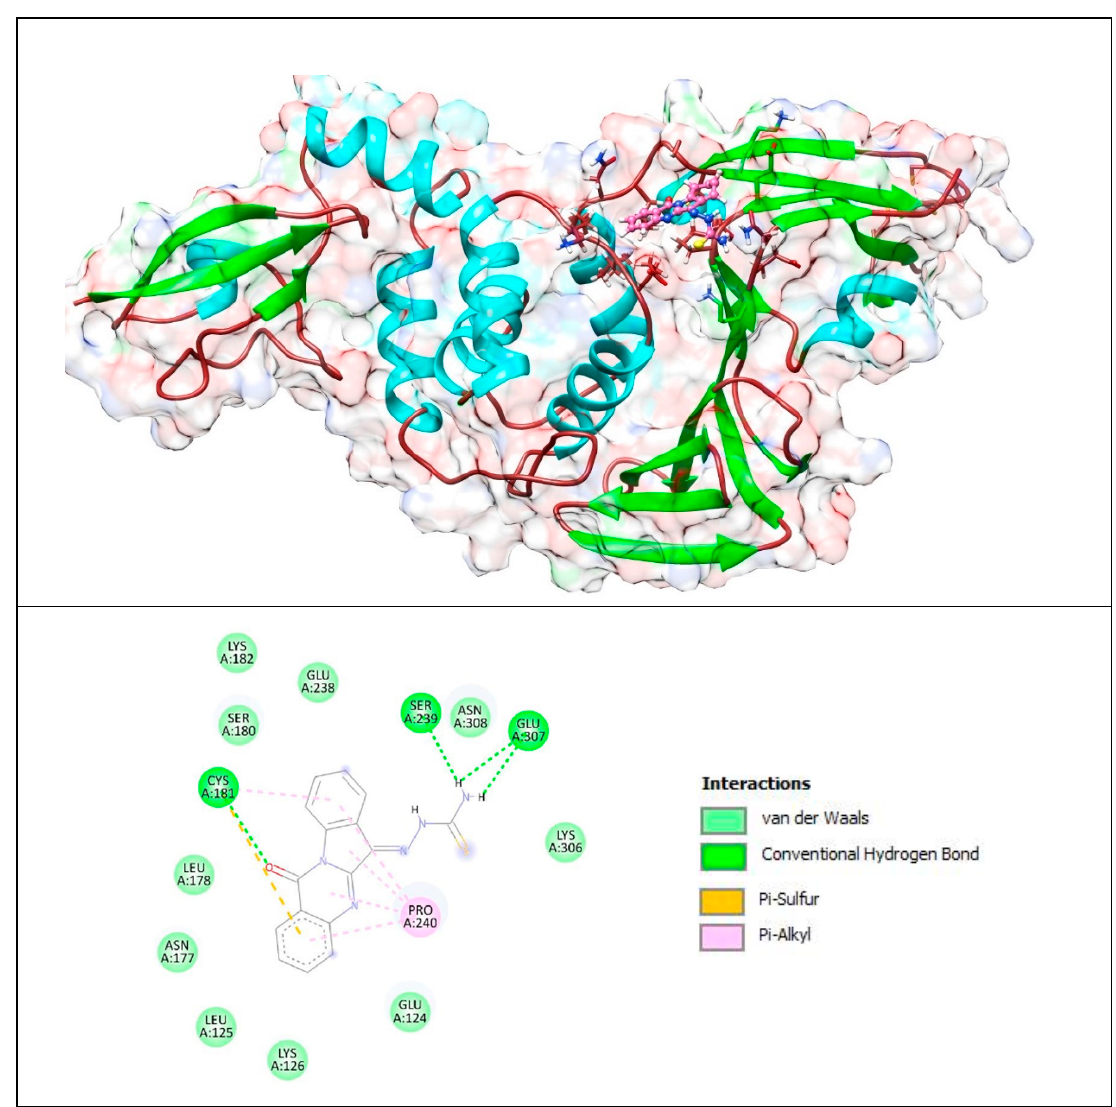
Figure 10. Complex of PLpro with T8H-TSC. The upper panel shows a 3D model of PLpro with a binding site (cavity) on its surface for the T8H-TSC compound. The lower panel shows the binding mode of T8H-TSC with the amino acid residues of PLpro. Figure 10 was created with UCSF Chimera ( upper panel ) and BIOVIA Discovery Studio Visualiser ( lower panel ) and shows the best docking pose of Compound T8H-TSC on PLpro. We can also see where T8H-TSC is placed on the PLpro surface and a general view of the complex of PLpro (green–cyan–brown) with T8H-TSC (pink). The secondary structure of the protease behind the molecular surface (created with 90% transparency for better presentation of the molecule) is also shown.